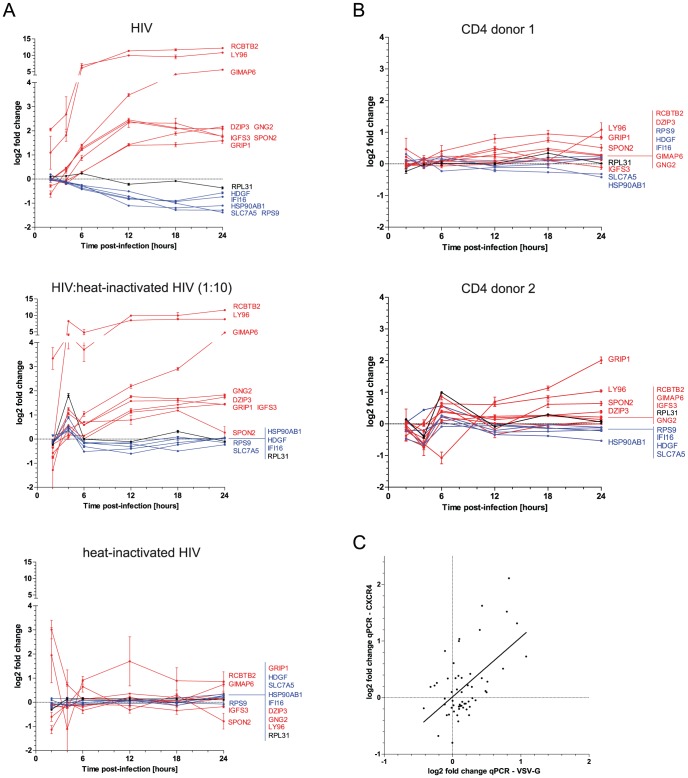
Core gene validation.RT-qPCR was used to validate key patterns of expression using heat-inactivated virus, primary cells, and natural viral envelope. (A) Analysis of 14 representative genes using competent or heat-inactivated HIV-based vector. The graphs depict the 24 dynamics of expression (log2 fold change of VSV.G pseudotyped HIV-infected over mock) of eight upregulated genes (red lines), five downregulated genes (blue), and one control (RPL31, black line) in SupT1 cells exposed to similar amount of viral particles, only competent HIV (top panel), 1∶10 competent HIV∶heat-inactivated HIV (middle panel), and only heat-inactivated HIV (bottom panel). (B) Analysis in primary CD4+ T cells isolated from two healthy blood donors. Depicted are the 24 dynamics of expression (log2 fold change of VSV.G pseudotyped HIV-infected over mock) of the upregulated (red), downregulated (blue), and control (black) genes. (C) Correlation analysis of RT-qPCR for the 14 representative genes at all time points in primary cells (donor 1) infected by VSV.G or CXCR4 pseudotyped HIV. Log2 fold change linear regression yielded r2 = 0.22, p<10−4.